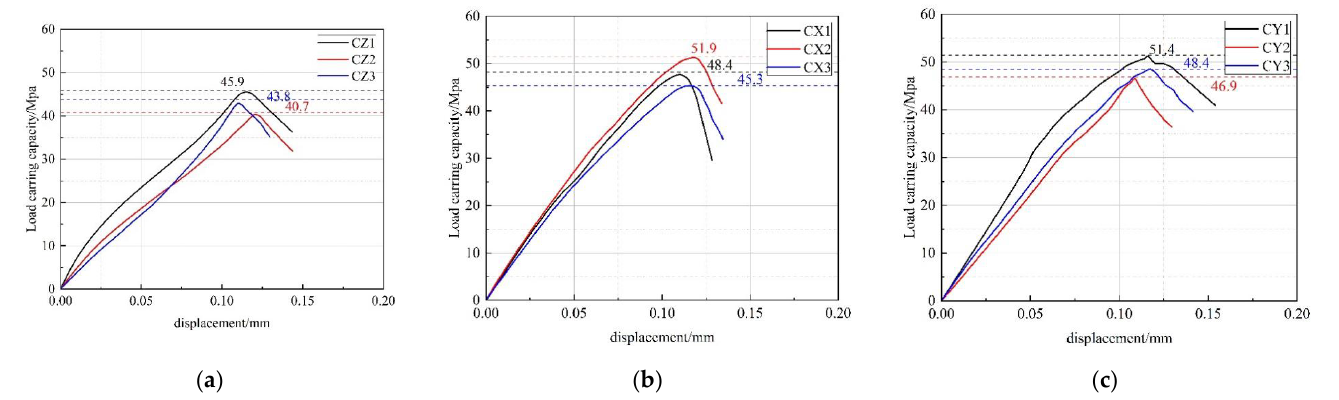
Figure 7. Load–displacement curves associated with the axial tension test. ( a ) CZ group specimens; ( b ) CX group specimens; ( c ) CY group specimens.